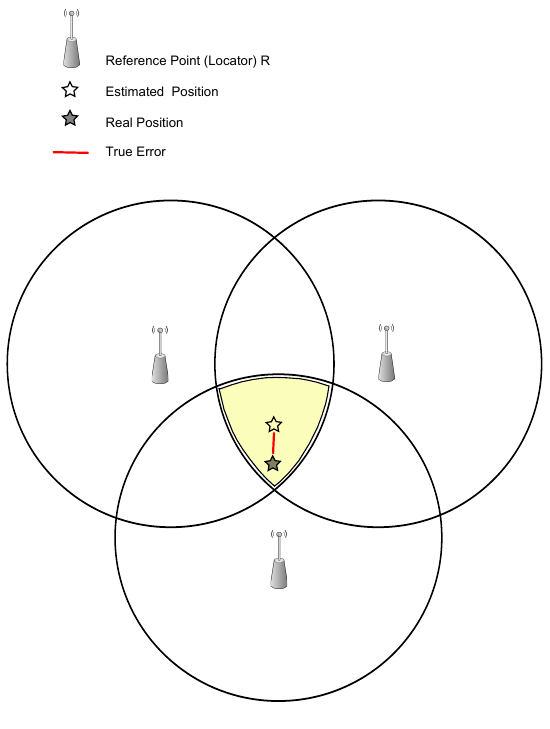
Figure 1. Positioning using reference